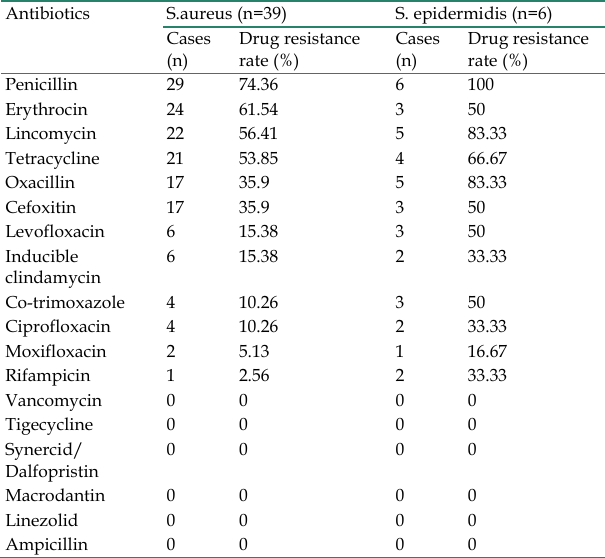
Table 5. The rate of drug resistance of the main Gram-positive